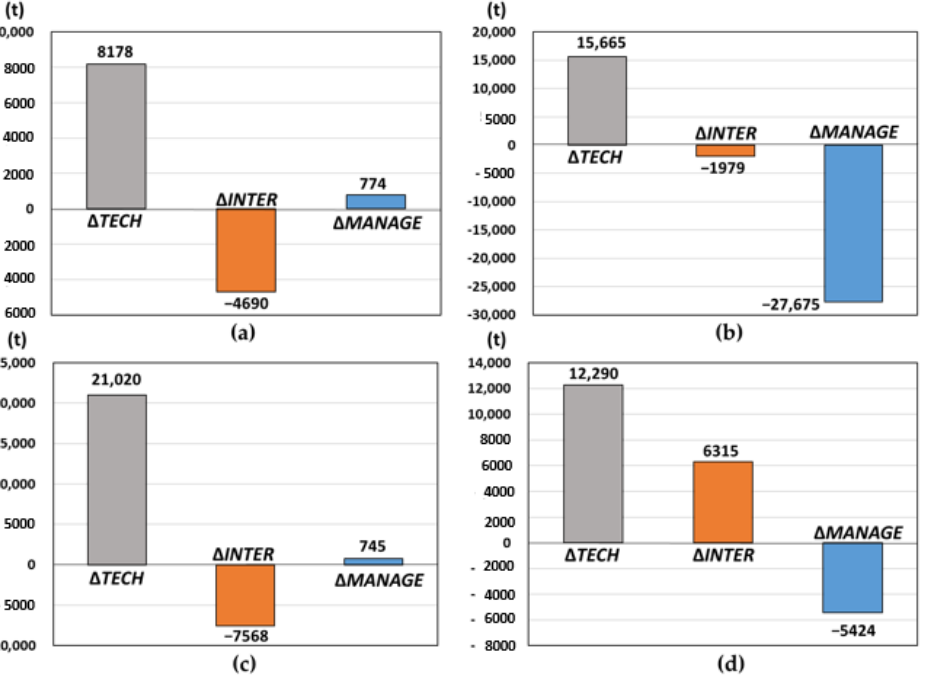
Figure 8. Breakdown of efficiency change effects for the SM group in the ( a ) east, ( b ) central, ( c ), west, and ( d ) northeast regions.